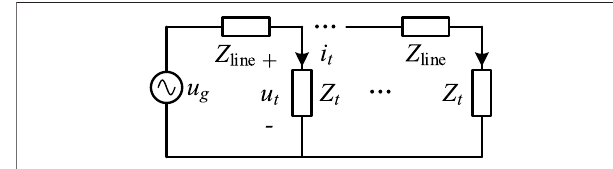
FIGURE 2 | Small-signal model of the MVDC